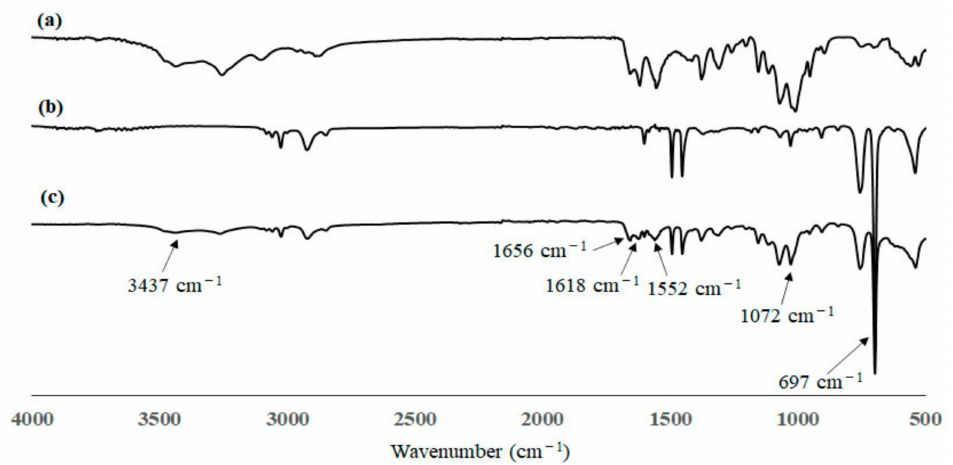
Figure 4. IR spectra of ( a ) the partially deacetylated (PDA-)ChNF film, ( b ) polystyrene, and ( c ) com- posite particles for run 2.